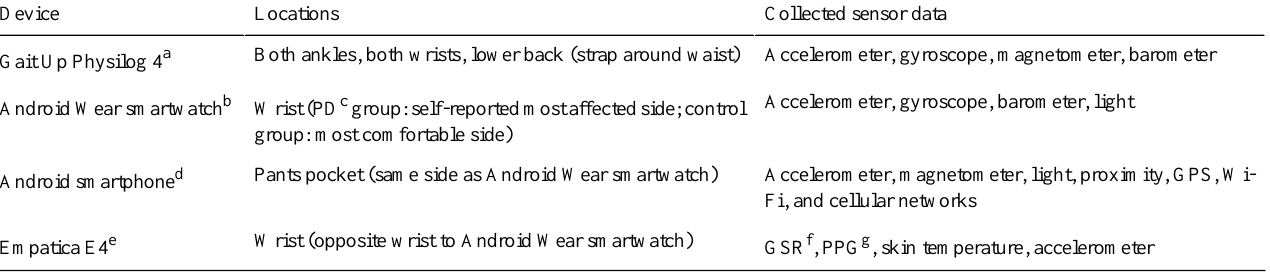
Collected sensor